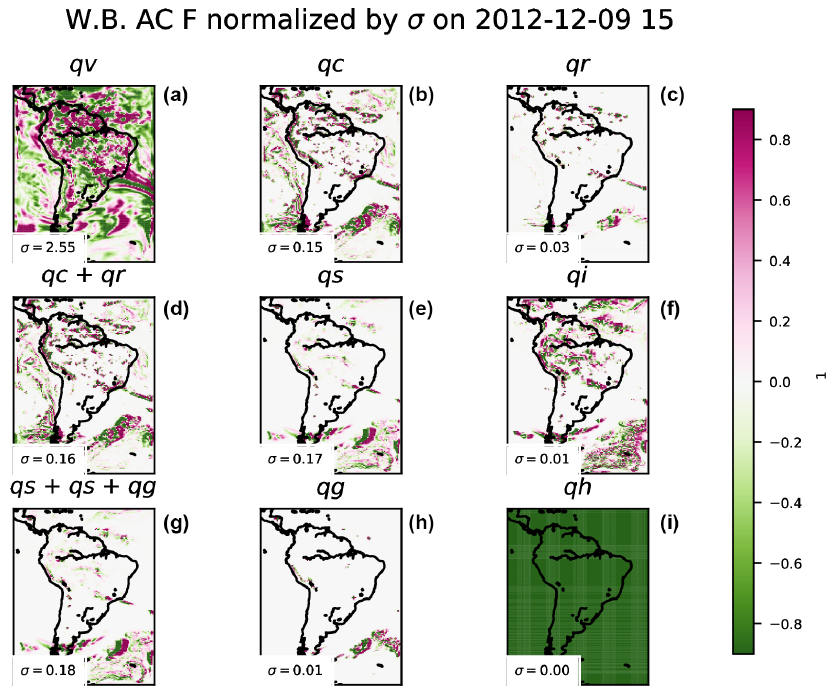
Figure 11. As in Fig. 10, but for water budget 3h accumulated vertically integrated horizontal advection F at a given time.